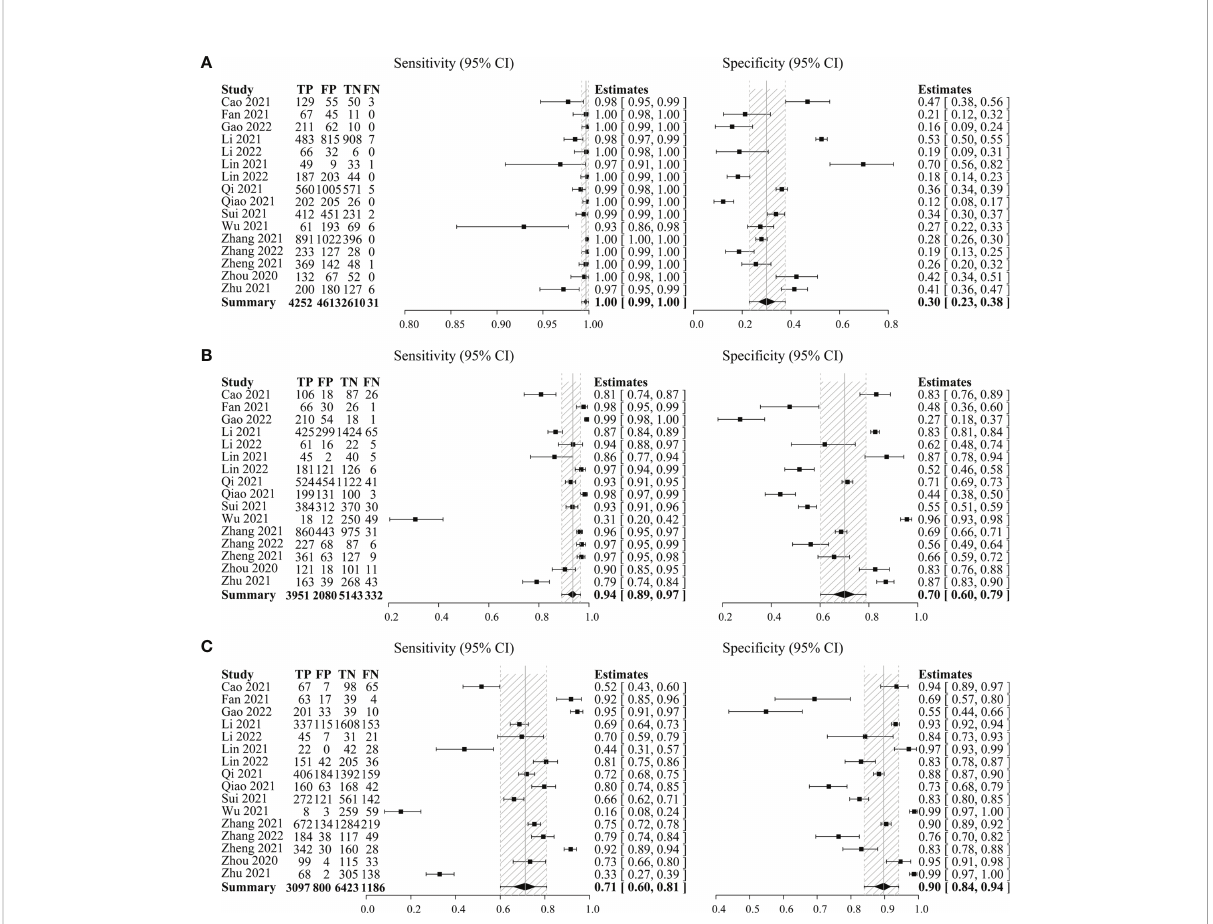
FIGURE 2 Forest plots with individual and pooled sensitivity and speci fi city of C-TIRADS 4A (A) , 4B (B) , and 4C (C) in the evaluation of thyroid nodules. The estimated accuracy for each study is plotted as a point and the 95% con fi dence interval (CI) as arrows. TP, true positivity; FP, false positivity; TN, true negativity; FN, false negativity; C-TIRADS, Chinese thyroid imaging reporting and data